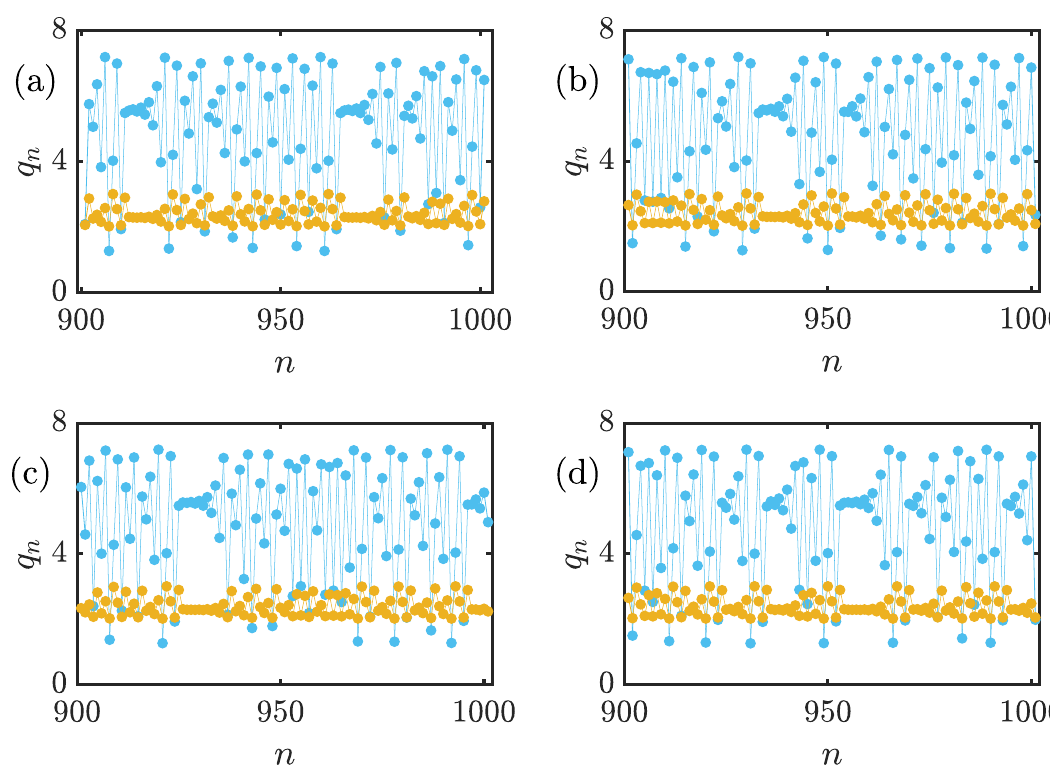
Fig 1. Time series of Eq (13) and its sensitivity to initial conditions with a = 6, b = 0.5, c 1 = 2, c 2 = 1, d 1 = 0.5, d 2 = 1, v 1 = 0.1, and v 2 = 1. The blue and yellow dots represent the output of the leader ( q 1 ) and the follower firm ( q 2 ). The initial conditions are (a) q 1 (0) = q 2 (0) = 1, (b) q 1 (0) = 1.0001, q 2 (0) = 1, (c) q 1 (0) = 1, q 2 (0) = 1.0001, and (d) q 1 (0) = 1.0001, q 2 (0) = 1.0001. There are bounded but unpredictable and unordered variations in the time series that resemble chaotic behavior. Also, changing the initial conditions in the order of 10 − 4 causes an entirely different time series, the sensitive dependence of chaotic models to initial conditions.